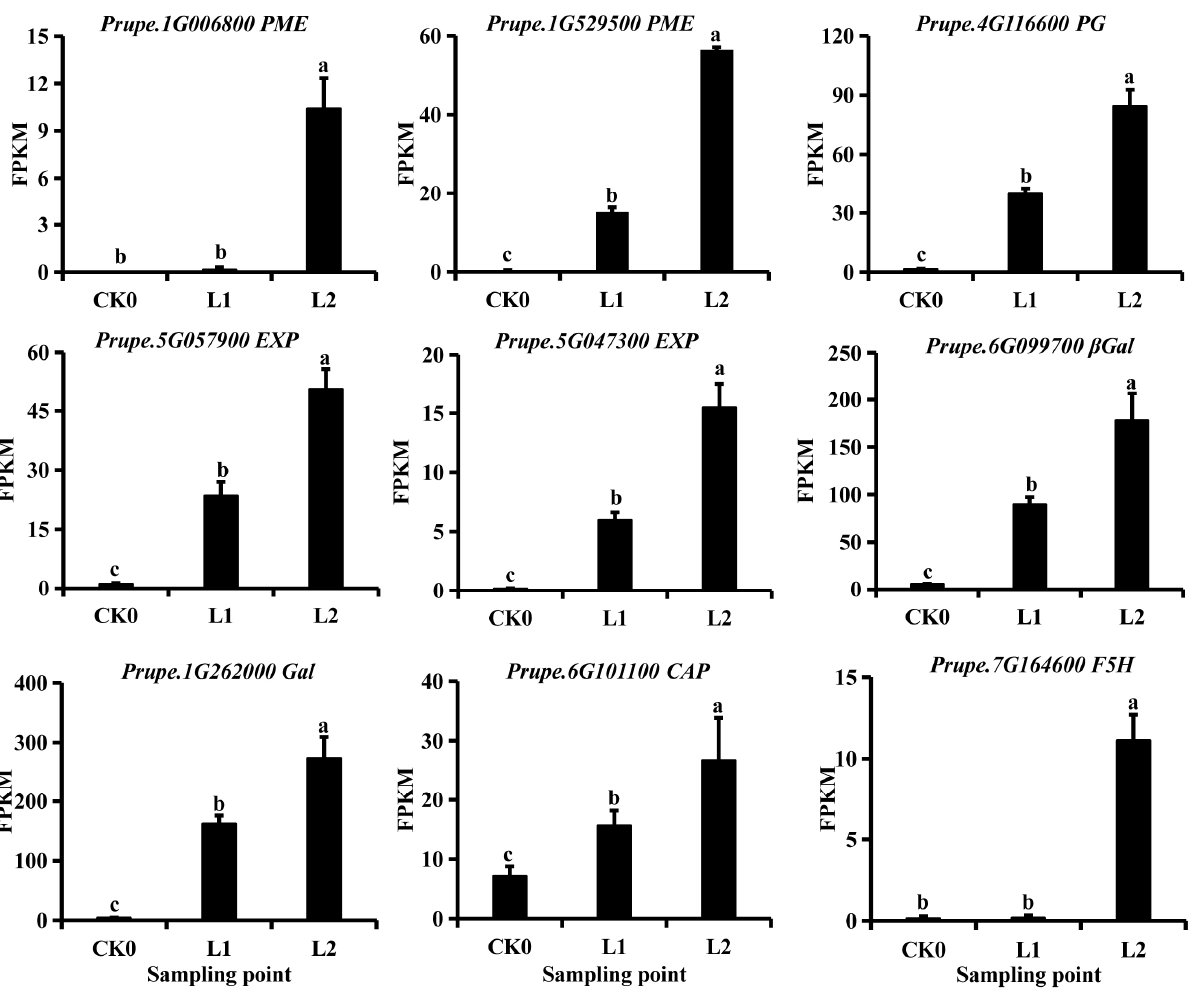
Figure 4. Expression profiles of genes involved in cell wall metabolism. PG, polygalacturonase; PME, pectin methylesterase; Exp, expansin; Gal, galactosidase; -Gal, -galactosidase; F5H, ferulate-5-hydroxylase; CAP, arabinogalactan protein (AGP). The error bars represent the standard error (SE) calculated from three independent biological replicates; in each plot, bars with the lowercase letters (a, b, or c) are significantly different ( p < 0.05).